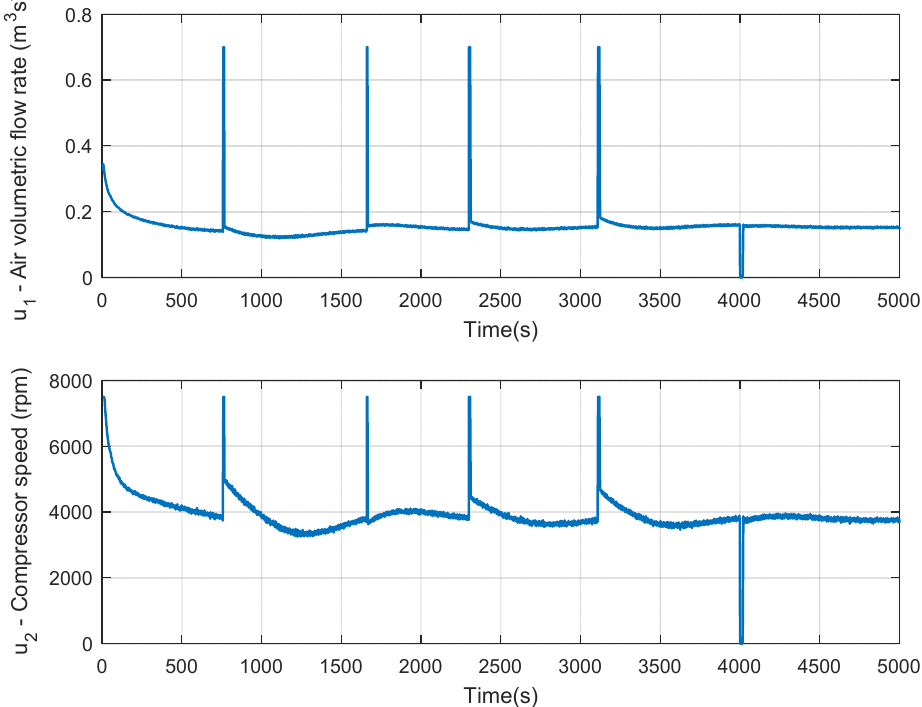
Figure 4. Control signals for tracking performance of VS DX A/C system with internal disturbances . Trajectory tracking with disturbances test has operation conditions close to reality.